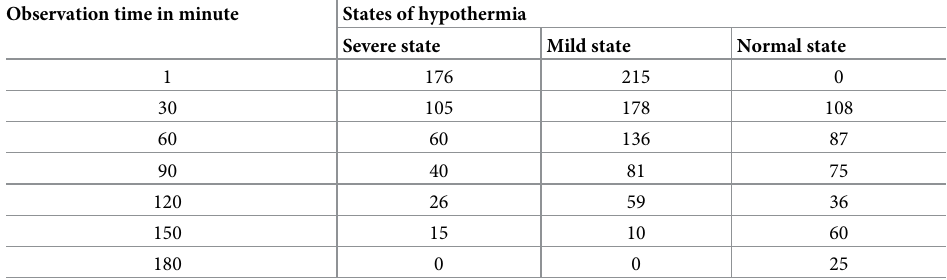
Table 1. The states of hypothermia among newborns at Arba Minch General Hospital, Ethiopia,